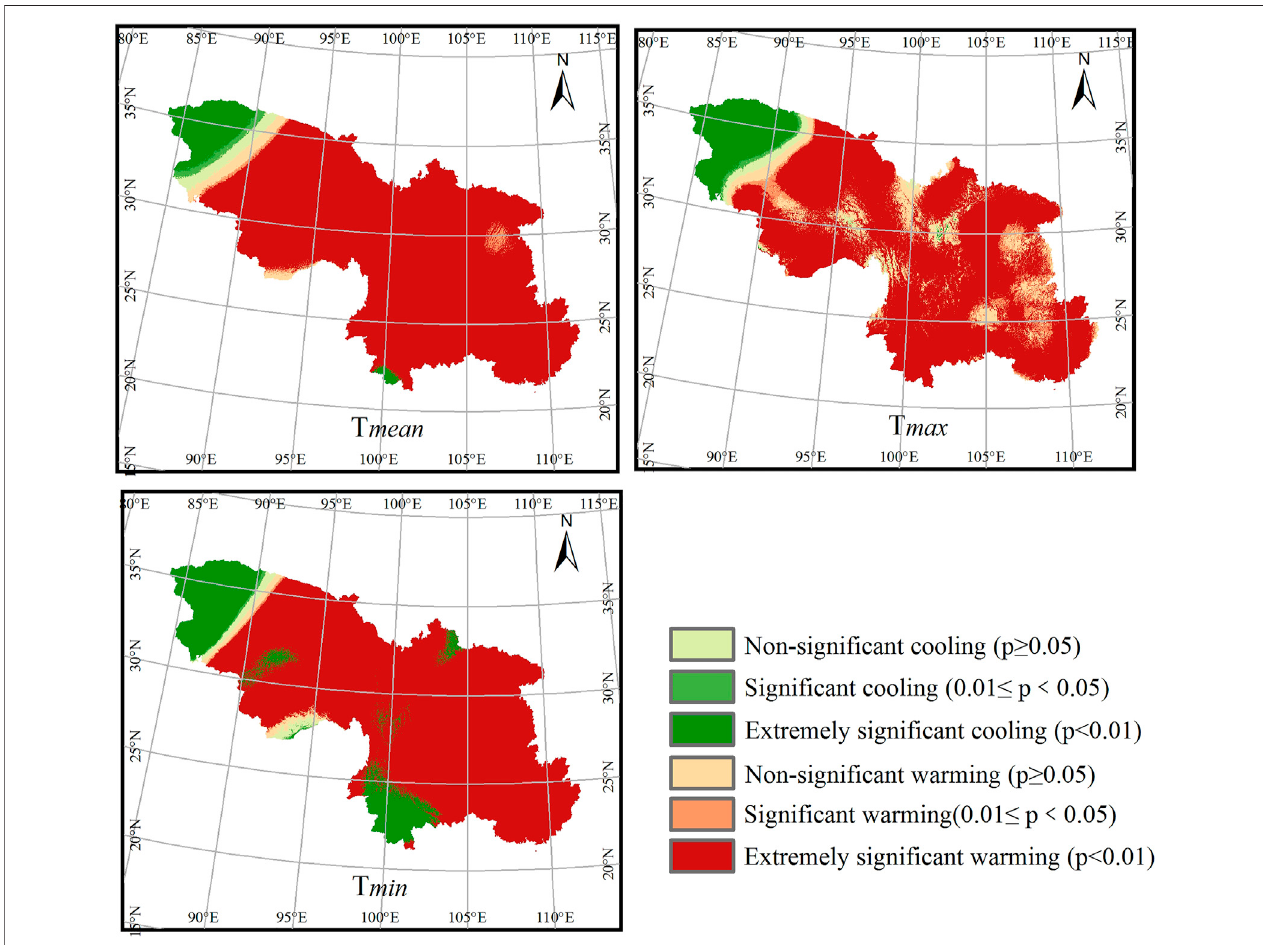
FIGURE 6 | Trends of annual NSAT over Southwest China for the period 1969 – 2018. Panels (A – C) correspond to the mean annual, mean annual maximum, and minimum temperatures, respectively.